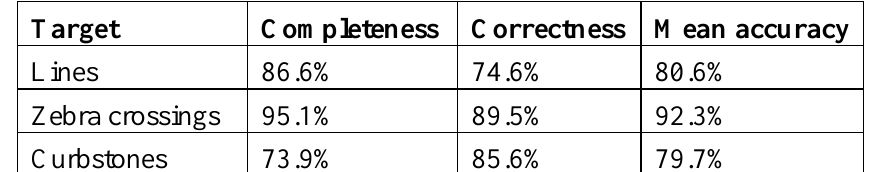
Table 1. Assessment of modelling